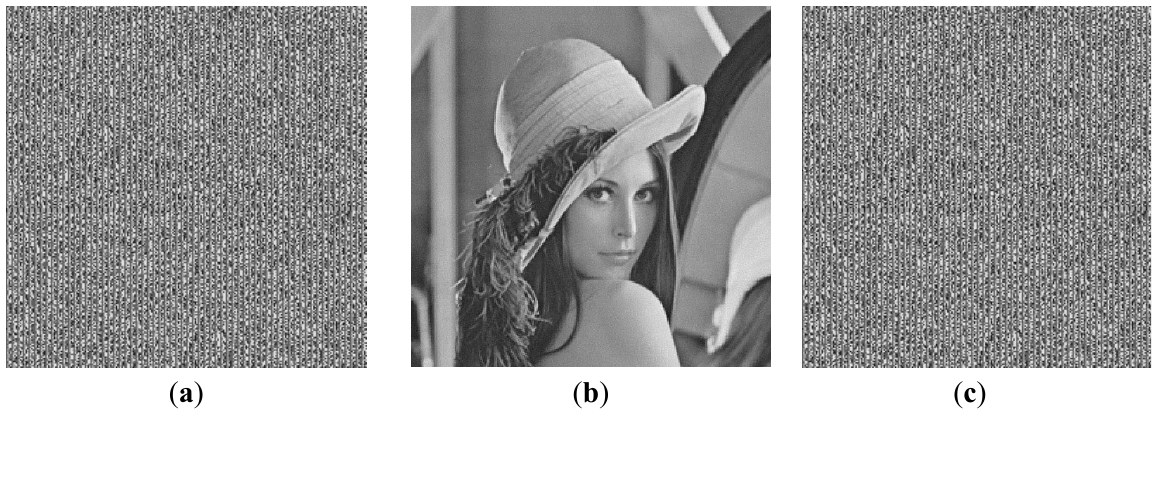
Figure 8. ( a ) The array transformed from the secret text with m = 2. ( b ) The image embedded with hidden data with α = 0.05. ( c ) The recovered transformed array. The recovery accuracy is